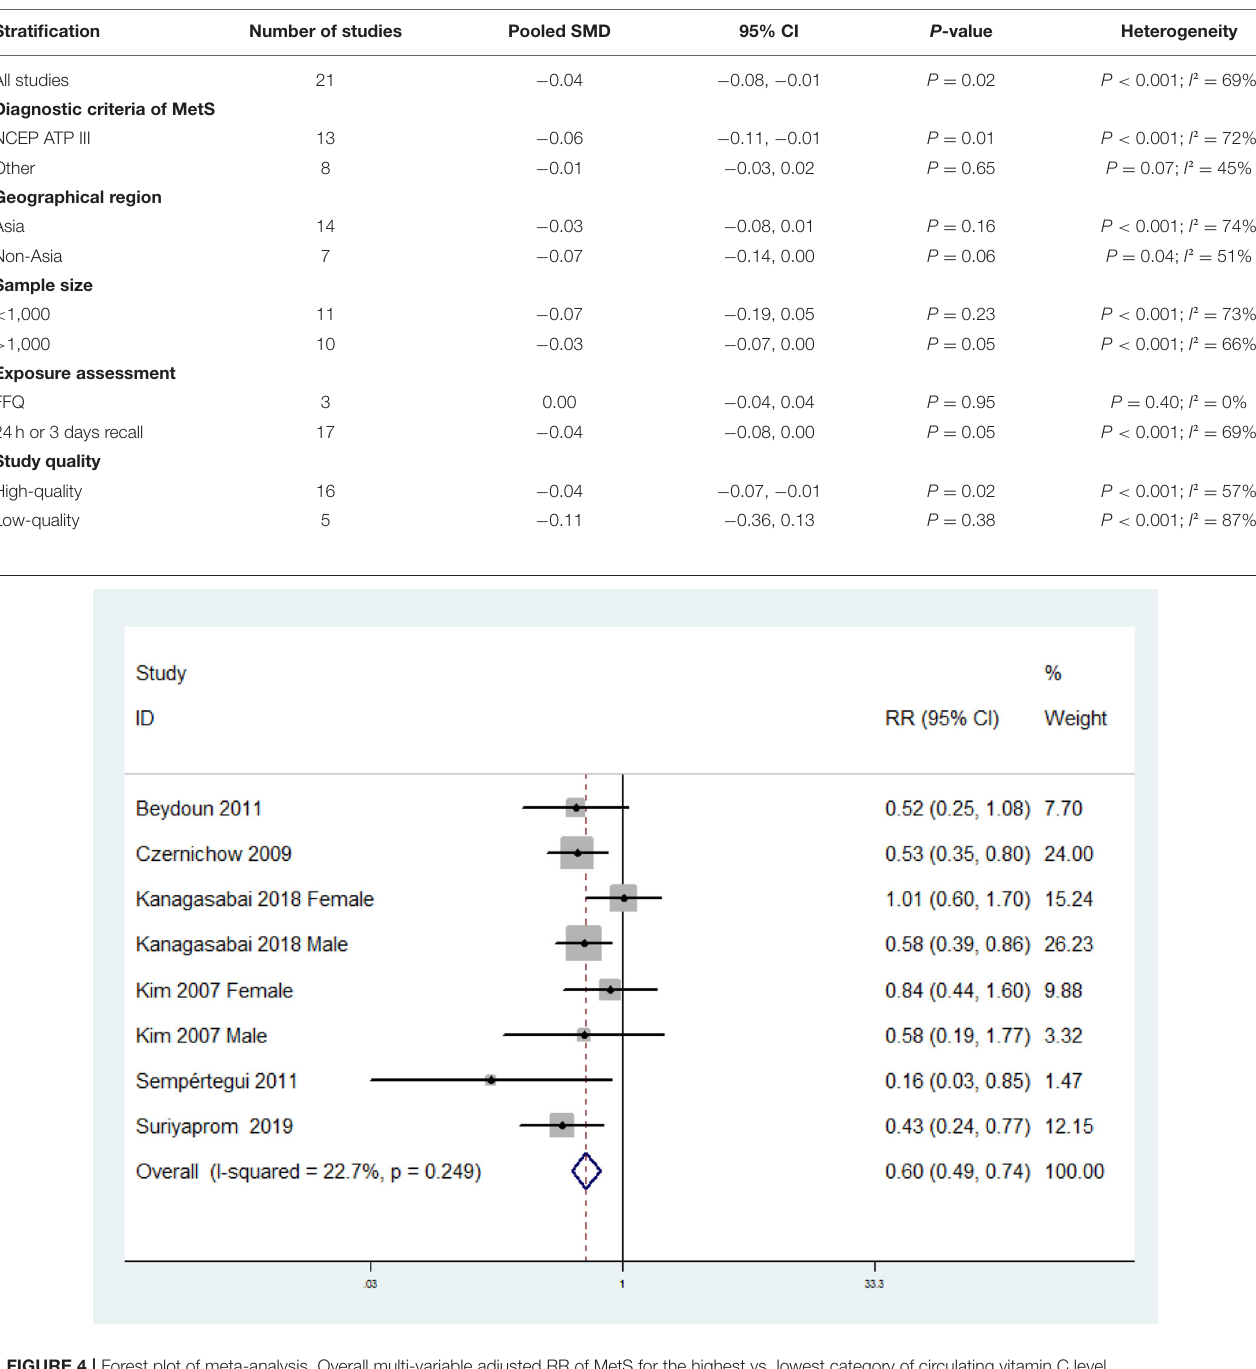
RR of MetS for the Highest vs.